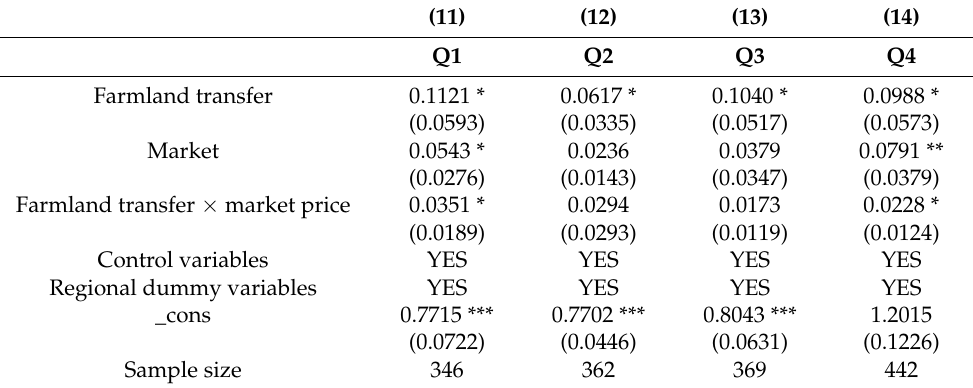
Table 7. Moderating effects of market factors grouped by household income